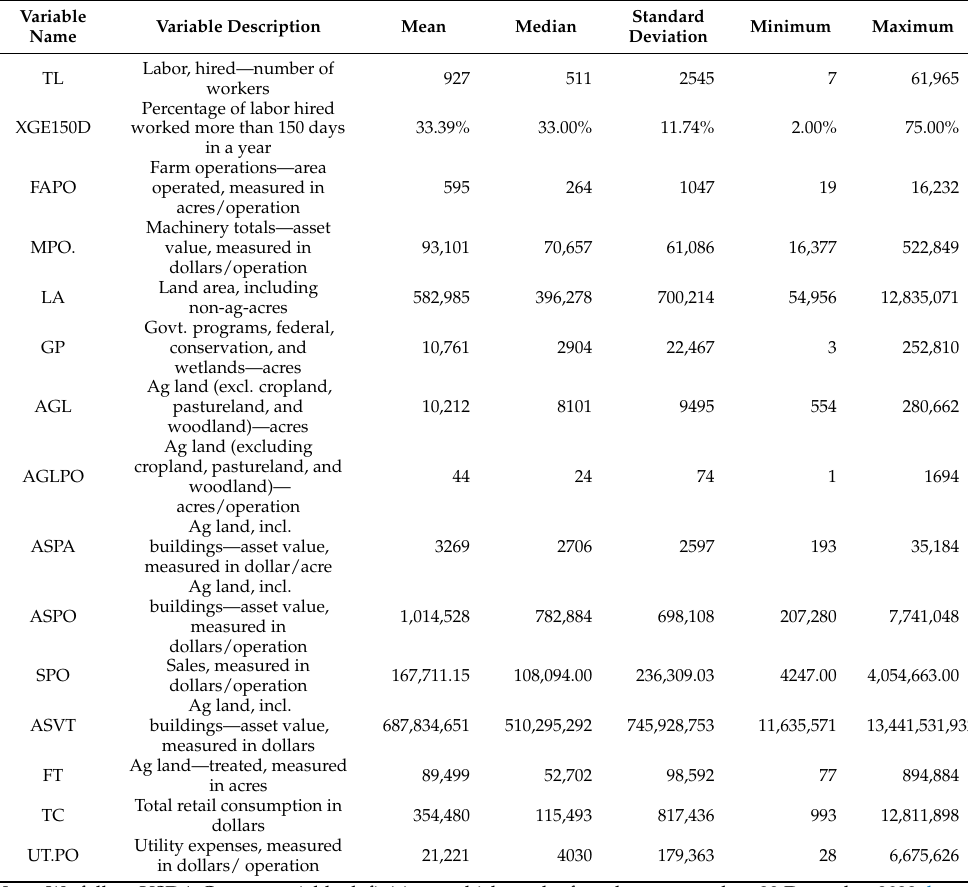
Table 1. Descriptive statistics for the 15 production potential